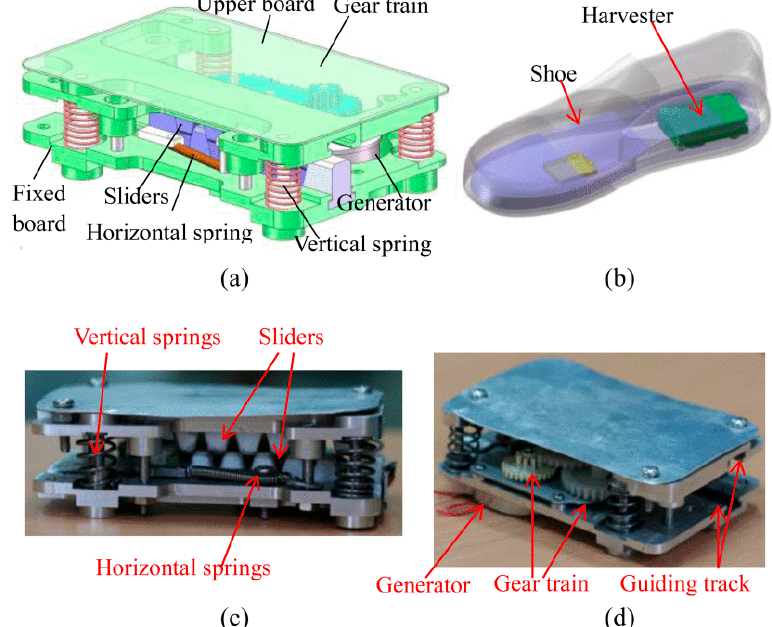
Figure 5. Foot-strike wearable energy harvester using a trapezoidal motion amplifier [44]: ( a ) 3-D model of in-shoe energy harvester; ( b ) harvester assembled in the heel area of a shoe; ( c ) front view; and ( d ) overview of the harvester prototype. Reproduced with permission from the IEEE.